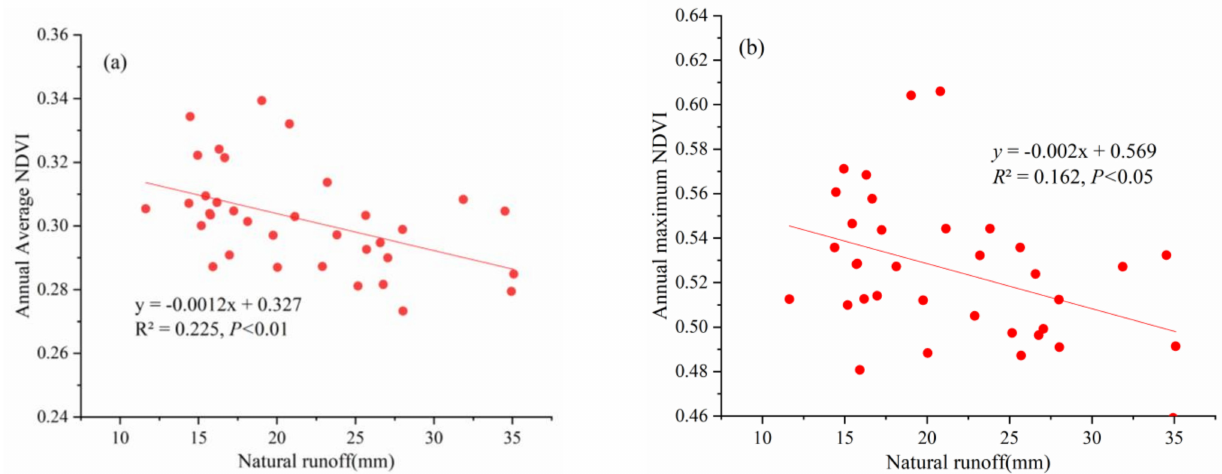
Figure 9. Correlation analysis of natural runoff with annual average NDVI and annual maximum NDVI in the mountain area of Yongding River from 1982 to 2016. ( a ) correlation analysis of natural runoff with annual average NDVI in the YRMA from 1982 to 2015; ( b ) correlation analysis of natural runoff with annual maximum NDVI in the YRMA from 1982 to